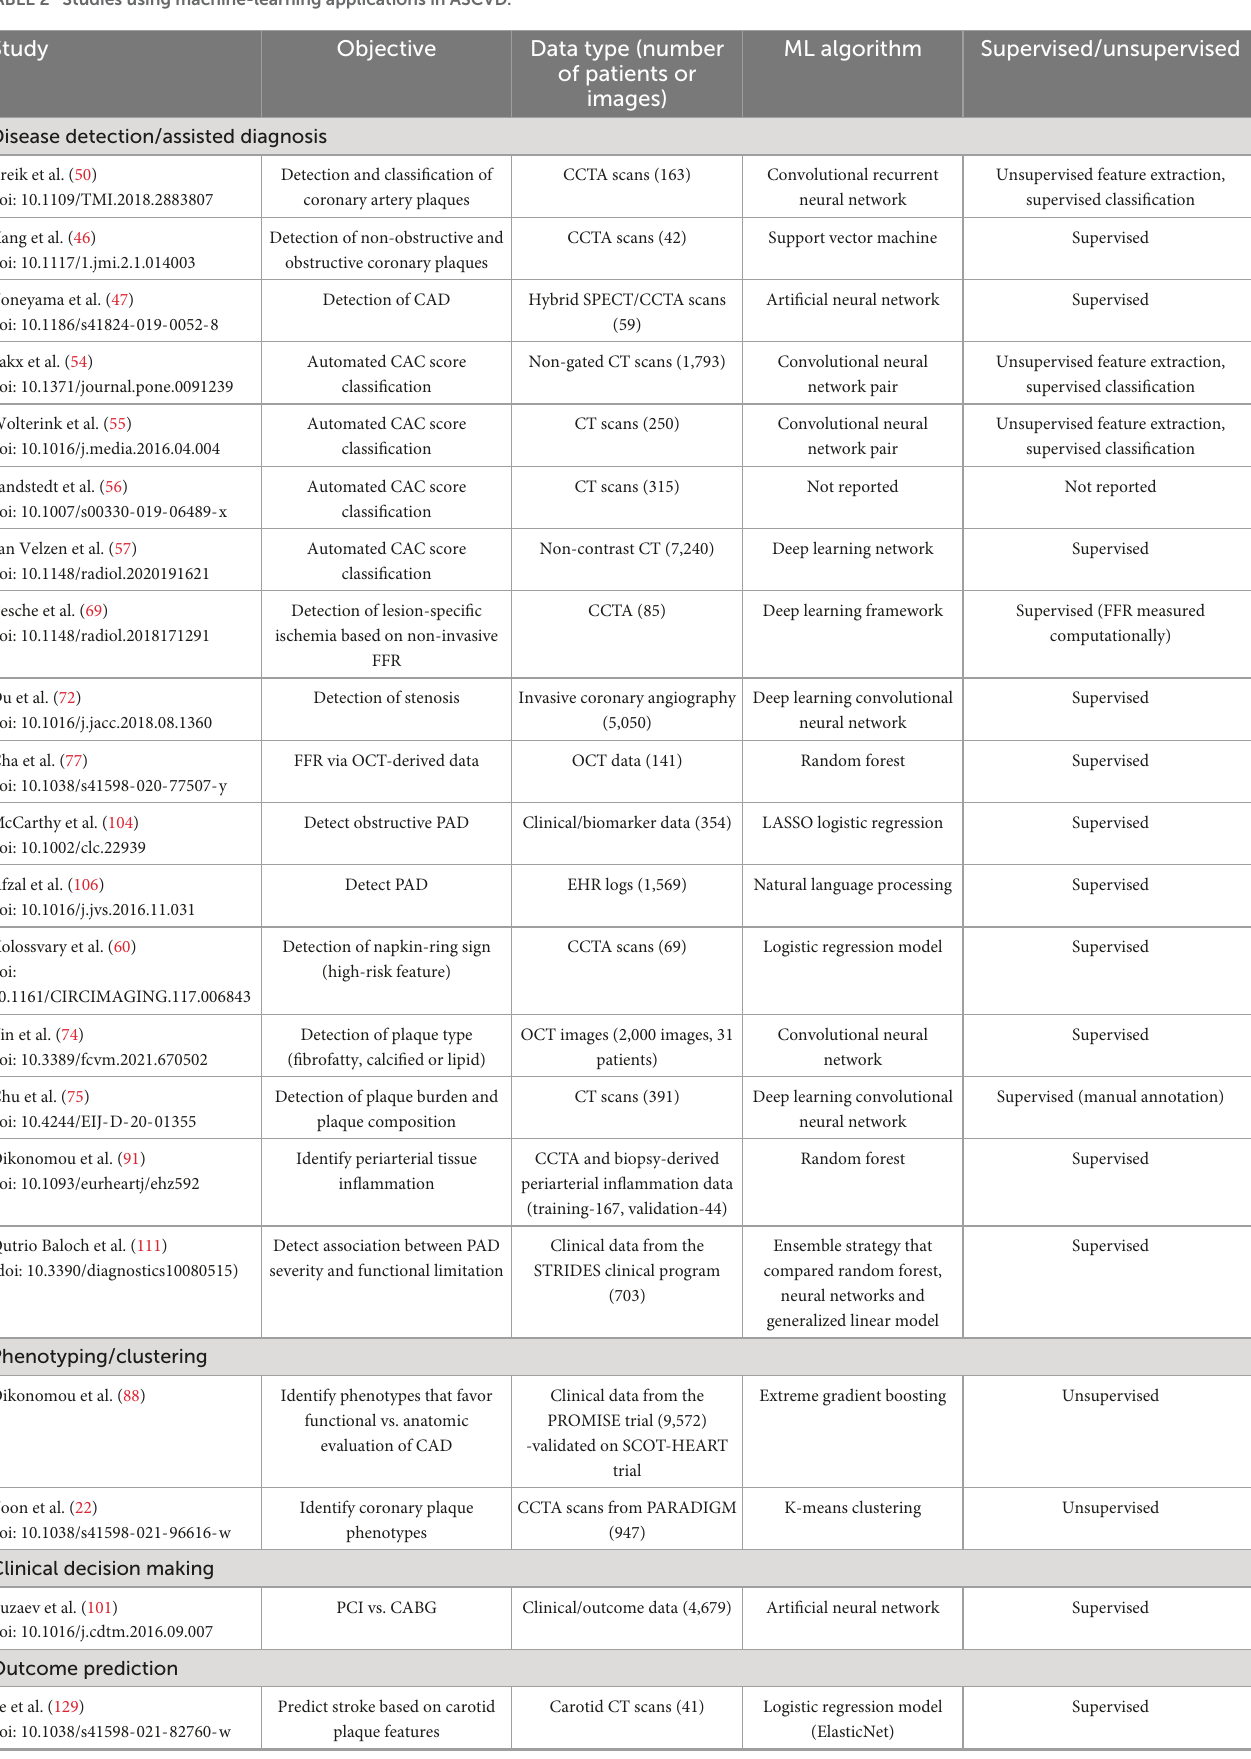
TABLE 2 Studies using machine-learning applications in